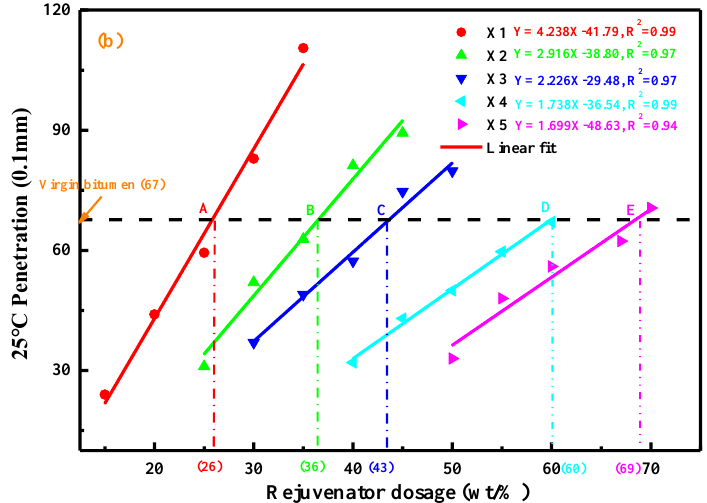
Figure 5. Effects of complex rejuvenator dosage on the penetration of rejuvenated binders. ( a ) RJ-based compound rejuvenators; ( b ) RX-based compound rejuvenators.